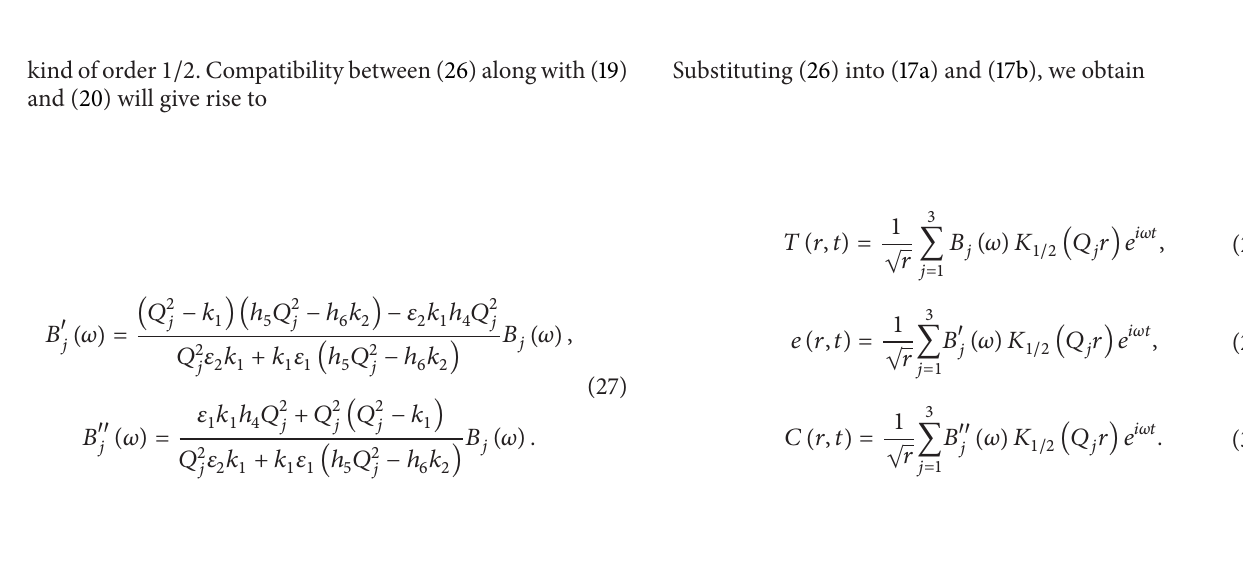
Figure 6: Variation of tangential stress 𝜎 𝜙𝜙 with radius 𝑟 (thermoelastic diffusion nonhomogeneity medium).